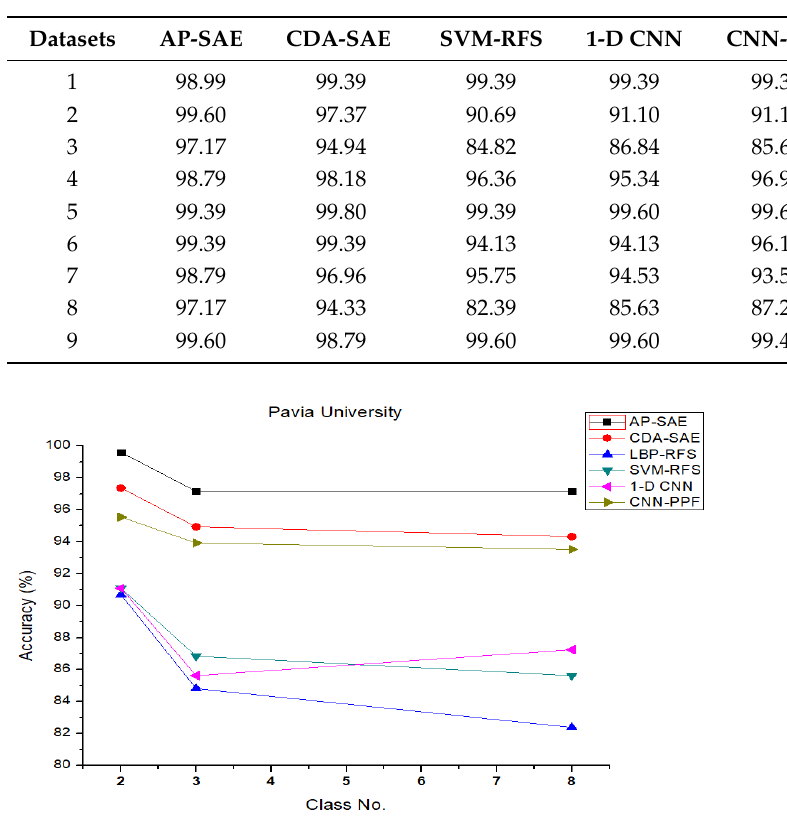
Table 9. Different methods of various types of accuracy comparison results for the Pavia Univer- sity dataset.